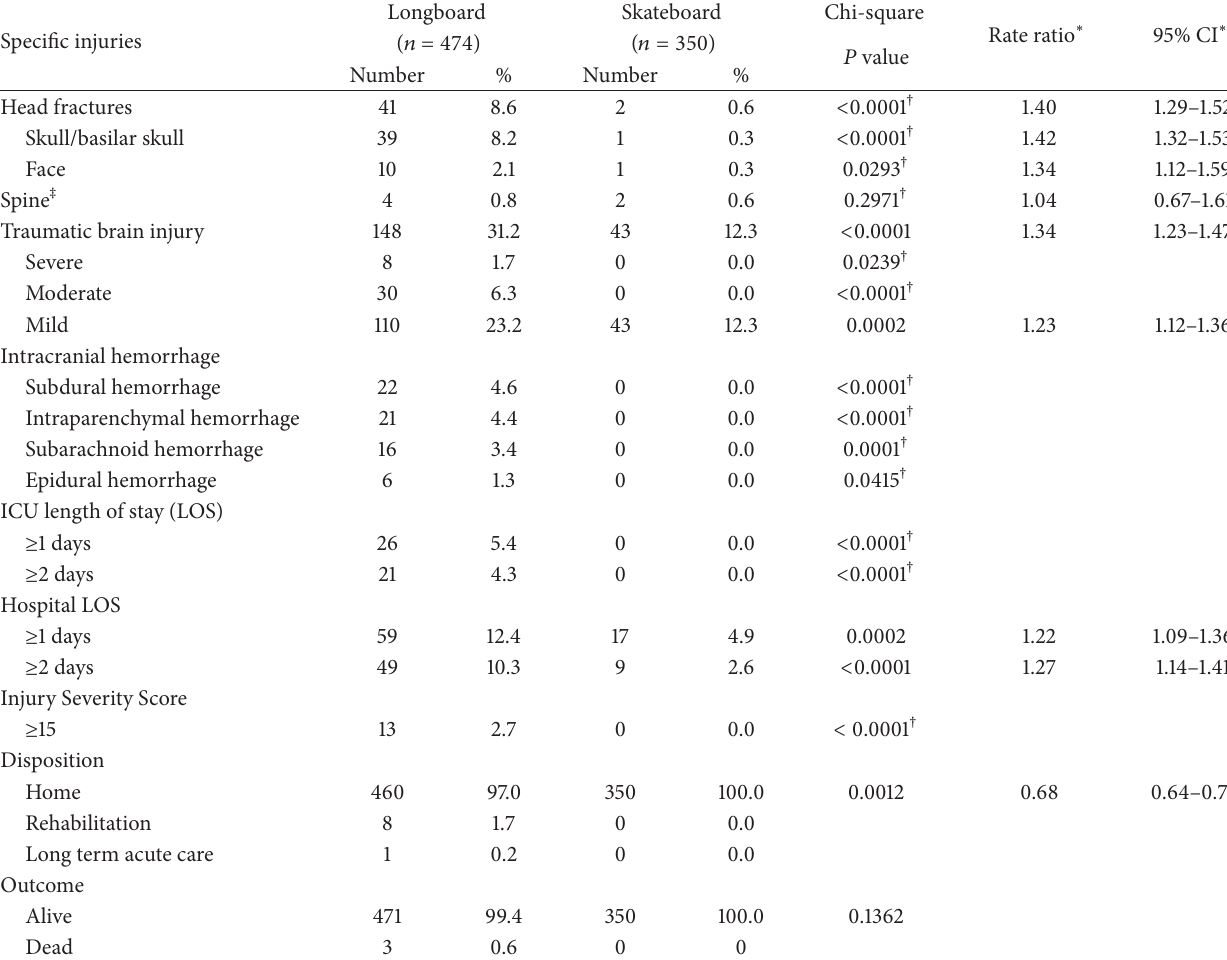
Table 3: Head fractures, spinal injuries, traumatic brain injury, and hemorrhages, along with selected outcomes according to long- board/skateboard status.